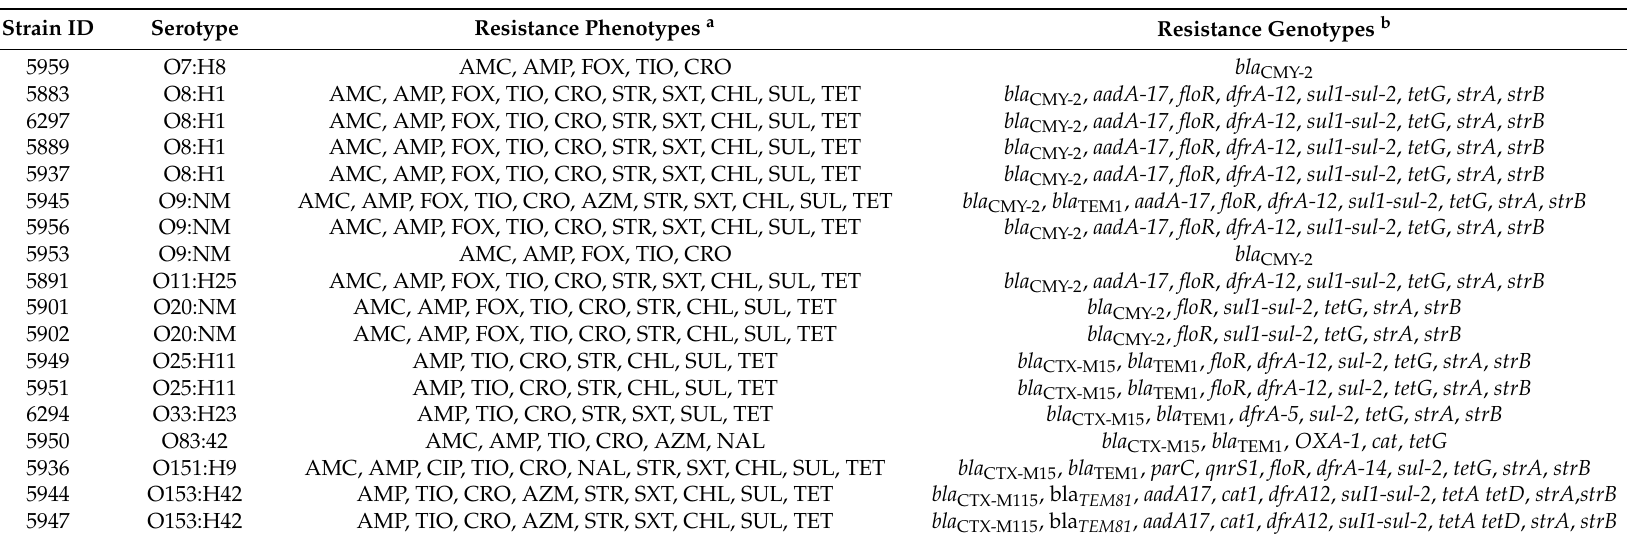
Table 3. Resistance phenotype and genotypes spectrum of selected 18 sequenced selected isolates used in this